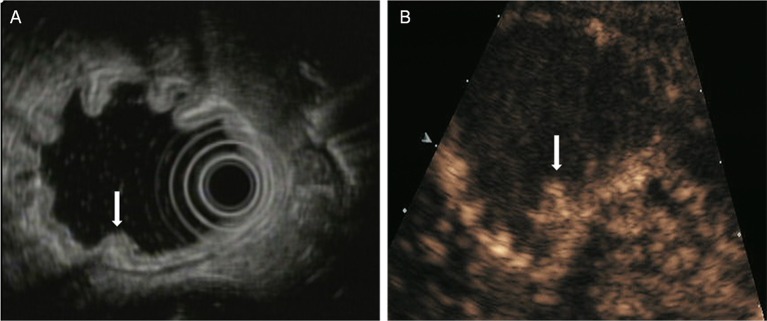
A case with T1 tumor located in the posterior wall of antrum. (A) EUS showed an small elevated lesion (arrow) involving the antral mucosa and submucosa. (B) DCEUS showed the lesion (arrow) invaded into the submucosal layer.